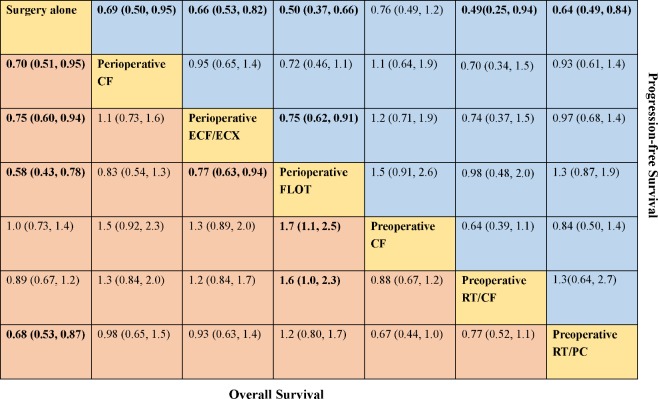
Comparative effectiveness of neoadjuvant treatments in network meta-analysis. Hazard ratio (95% credible interval) for comparisons are in cells in common between column-defining and row-defining treatment. Bold cells are significant. For overall survival, hazard ratio <1 favors row-defining treatment. For progression-free survival, hazard ratio <1 favors column-defining treatment.